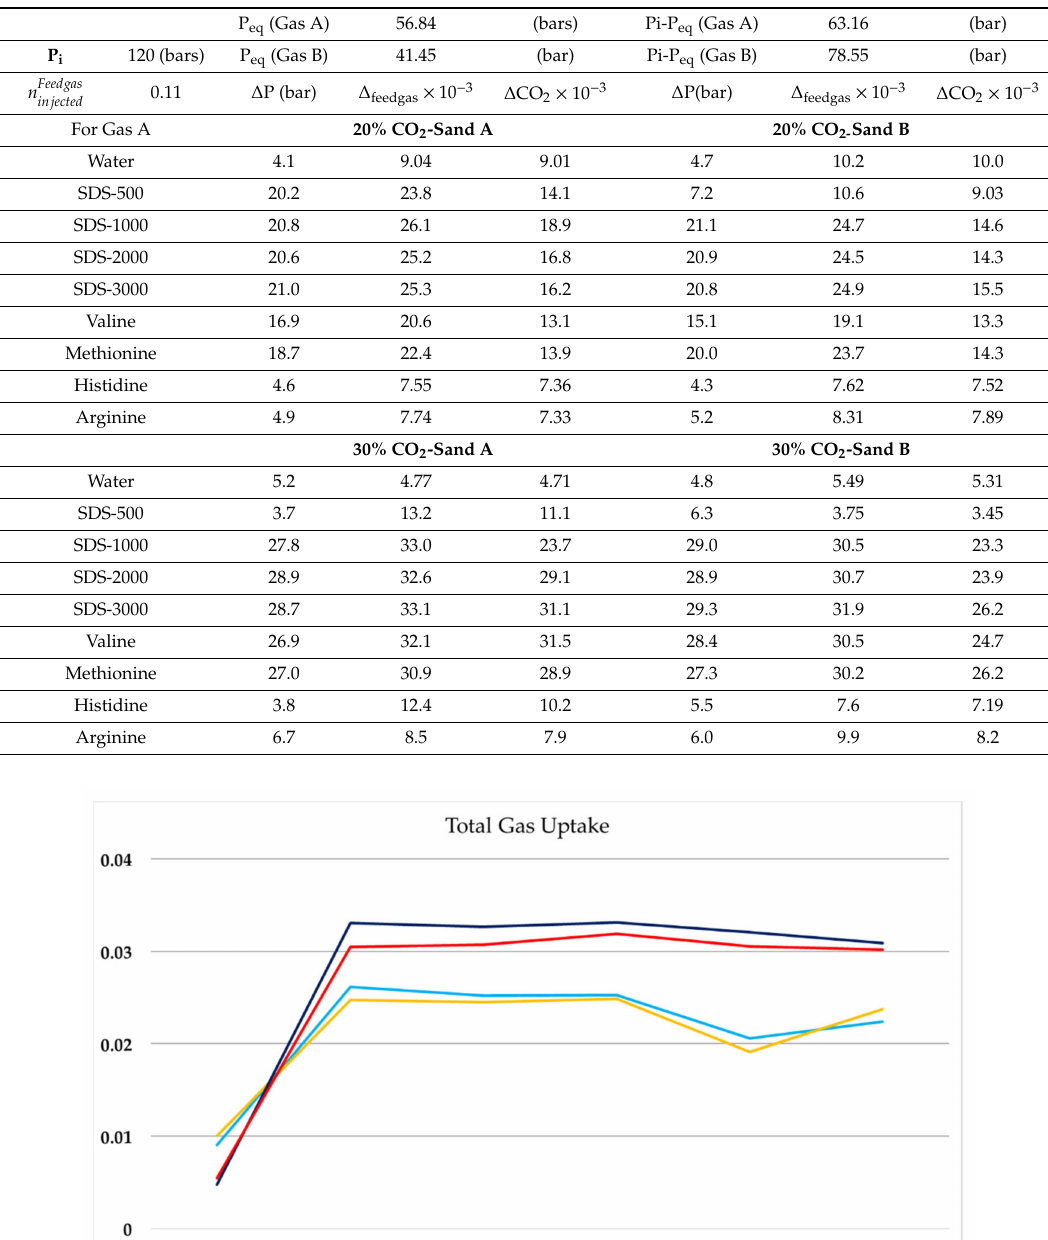
Table 3. Total gas uptake and CO 2 gas uptake calculations for di ff erent sands for 20 mol% CO 2 in N 2 (fresh run) and 30 mol% CO 2 in N 2 (fresh run). Initial conditions correspond to P i = 120 bar and T op = 1 ◦ C. GC analysis was performed after the fresh runs to quantify the moles of CO 2 and N 2 left in the gas phase after hydrate formed. P eq is calculated at identical pressure and temperature (P–T) conditions for the pure water case and di ff erent CO 2 concentrations in feed gas using CSMGem software.